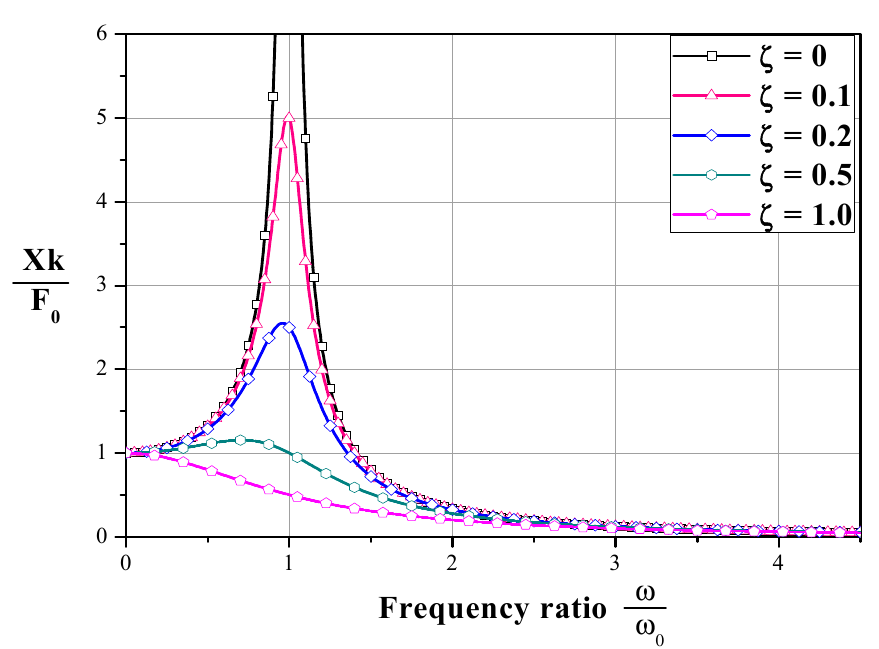
Figure 14. The motor bogie of the KTX.